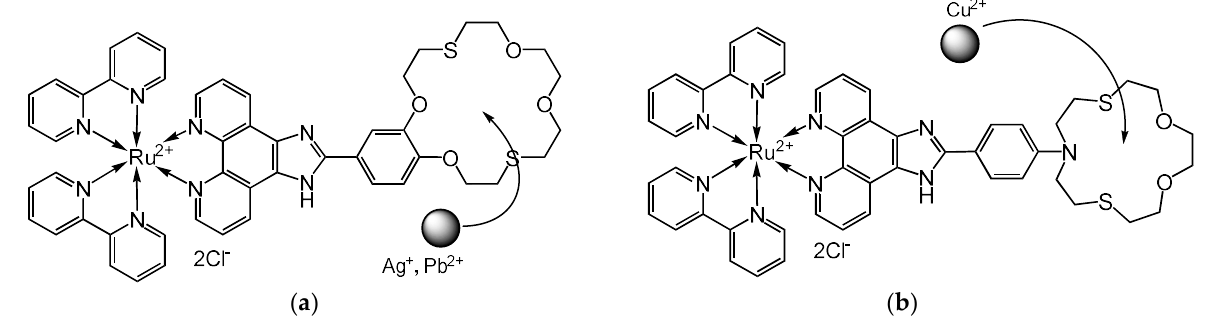
Figure 11. The structures of heterobimetallic Ru(II) complexes with ( a ) Ag + , Pb 2+ , and ( b ) Cu 2+ cat-